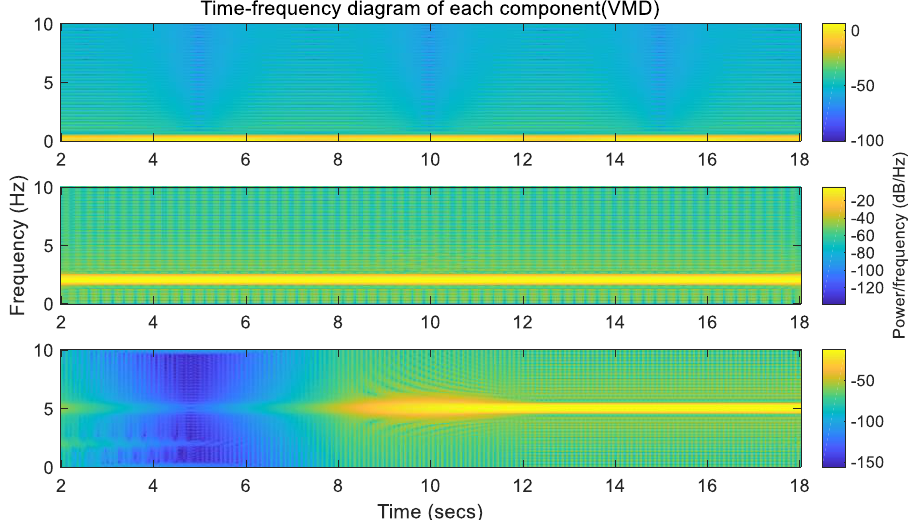
Figure 9. Time-frequency diagram of each component (VMD).